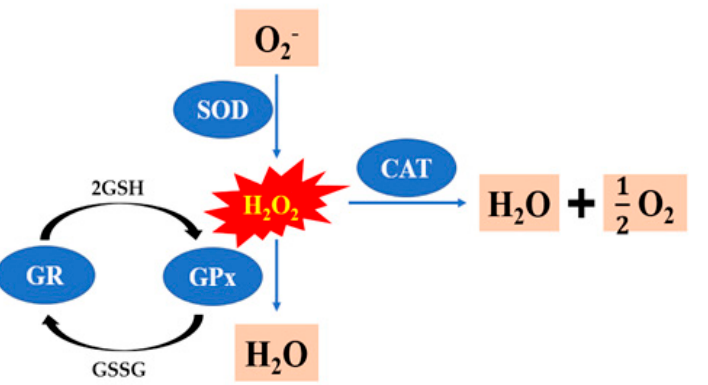
Figure 4. The reactions catalyzed by glutathione peroxidase (GPx), glutathione reductase (GR), superoxide dismutase (SOD), and catalase (CAT) to deal with ROS (H 2 O 2 ).